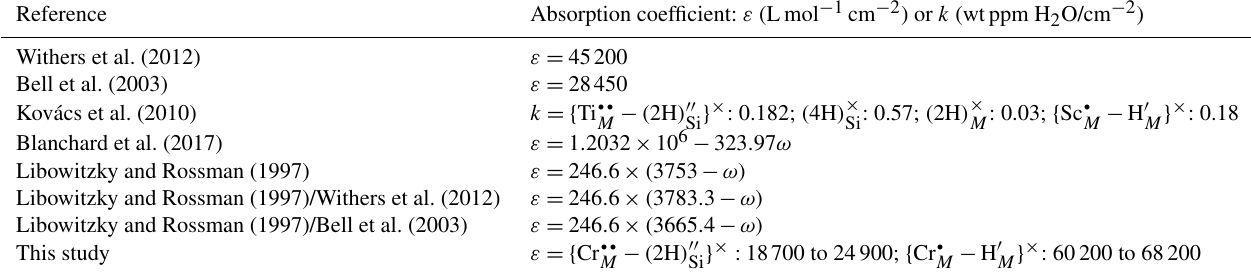
Table 3. Absorption coefficients. Where appropriate, ω is the wavenumber in cm − 1 . The Blanchard et al. (2017) calibration is based on their Fig. 8 and provided by Marc Blanchard (personal communication,